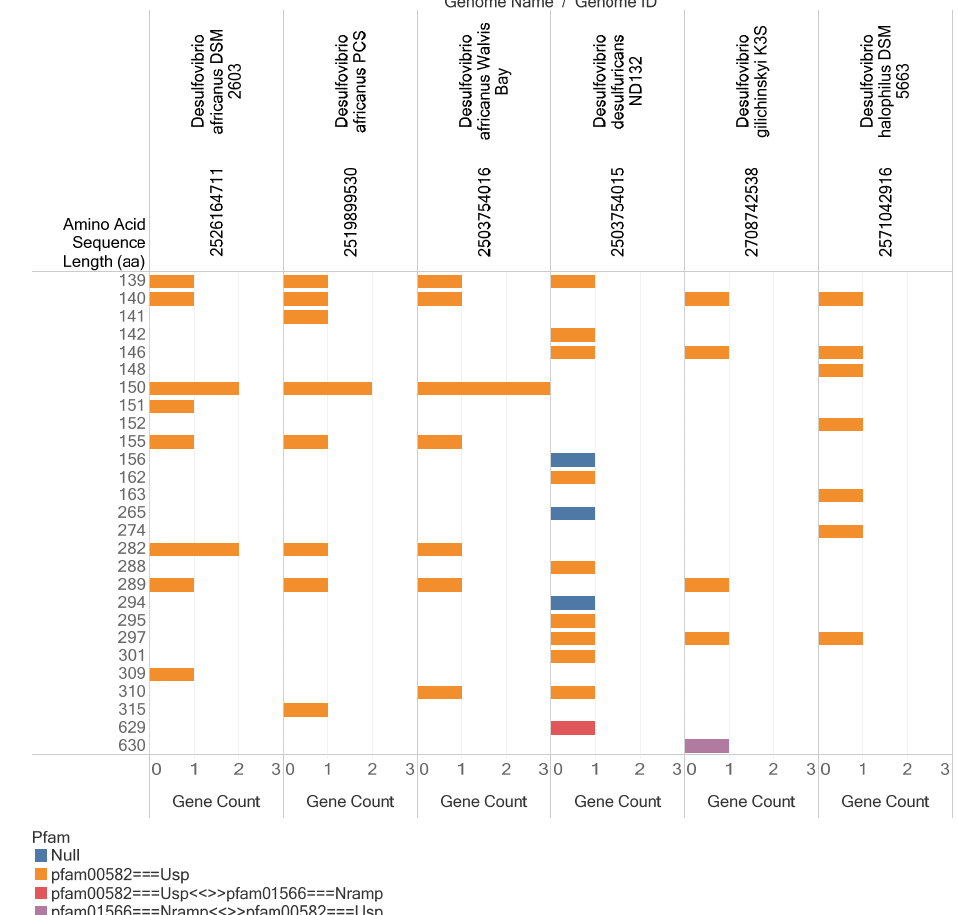
Figure 3. An overview of the protein sequence features for six Desulfovibrionaceae genomes including from five that encode the gene pair for mercury methylation. Desulfovibrio africanus , Desulfovibrio desulfuricans ND132 and Desulfovibrio halophilus DSM 5663 are mercury-methylating Desulfovibrionaceae species. The comparison visual reveals differences and commonalities in the amino acid sequence length, gene count and protein family (pfam) annotation that were obtained from the annotation in the Integrated Microbial Genomes and Microbiomes (IMG/M) system. For example, among the mercury-methylating Desulfovibrio africanus (reclassified as Desulfocurvibacter africanus ), there is an additional one gene encoding a 150 aa universal stress protein. The color of the bar plots represents the arrangement of the protein domains. Null means no protein domain predicted in the IMG/M resource.